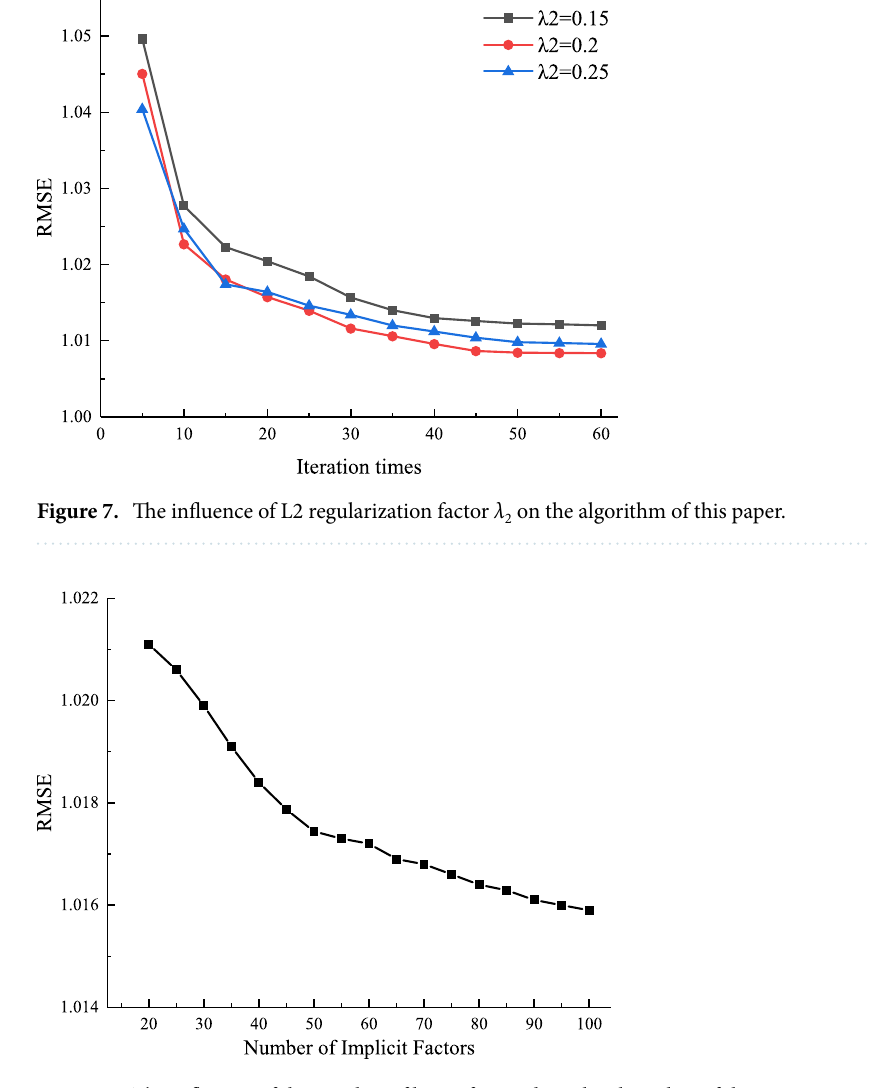
Figure 8. The influence of the number of latent factors k on the algorithm of this paper.